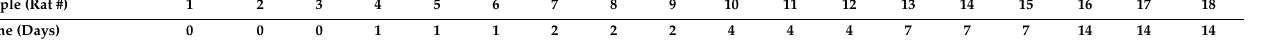
Table 2. Gut bacteria that changed over 14 days of broccoli